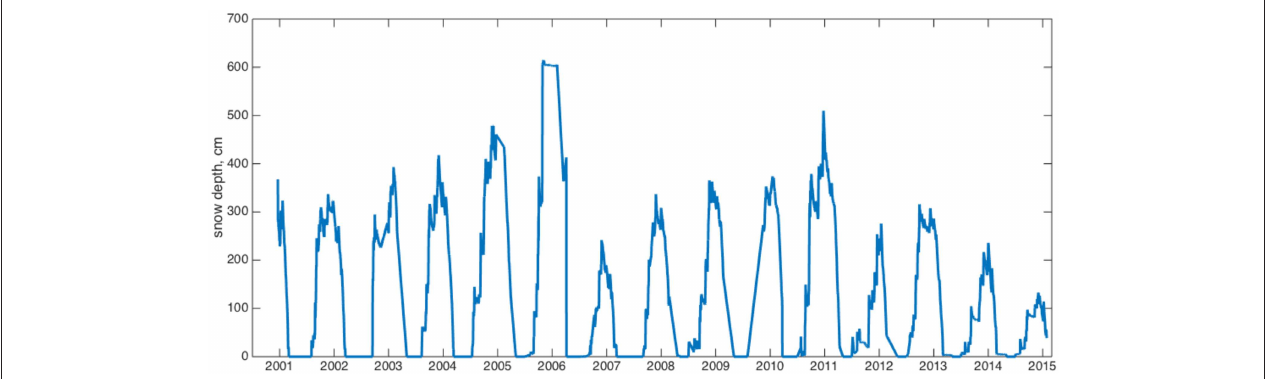
FIGURE 5 | Snow depth at CUES. April 1, 2001–2015 is marked on the horizontal axis. The plateau in 2006 is a result of the depth sensor being